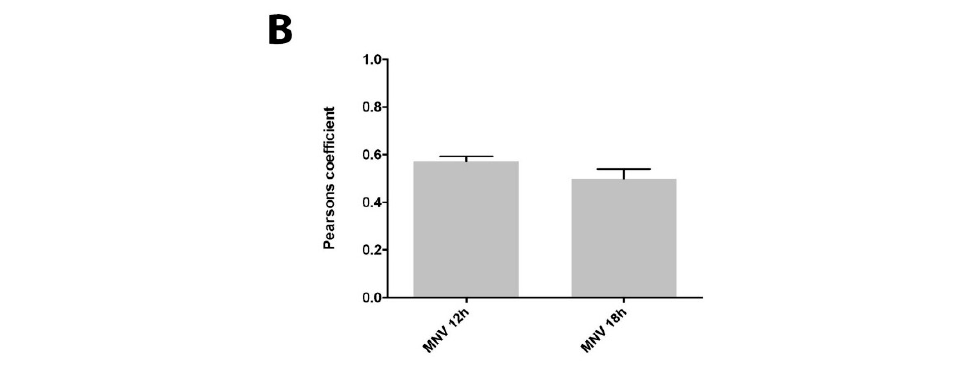
Figure 1. The replication complex (RC) of murine norovirus (MNV) co-localises with the endogenous guanine nucleotide exchange factor-H1 (GEF-H1) in the perinuclear area. ( A ) RAW264.7 cells were infected with MNV (multiplicity of infection (MOI) 5) and fixed at 12 h and 18 h after infection. Panels a, e, and i show the staining for the anti-GEF-H1 antibody (green); panels b, f, and j display the staining with an anti-non-structural protein 4 (NS4) antibody (red); panel c, g, and k represent the nuclear staining with DAPI (blue); and panels d, h, and l show the merged pictured of all channels. Stained cells were analysed via confocal microscopy and the co-localisation was quantified with the Pearson’s coefficient. ( B ) Quantitation of the Pearson’s coefficients. MNV 12 h = 0.57 ± 0.08 ( n = 16) and MNV 18 h = 0.50 ± 0.16 ( n = 14). Bars represent average ± standard error of the mean (SEM). Images were collected over triplicate experiments and analysed in GraphPad Prism (www.graphpad.com/scientific-software/prism/).